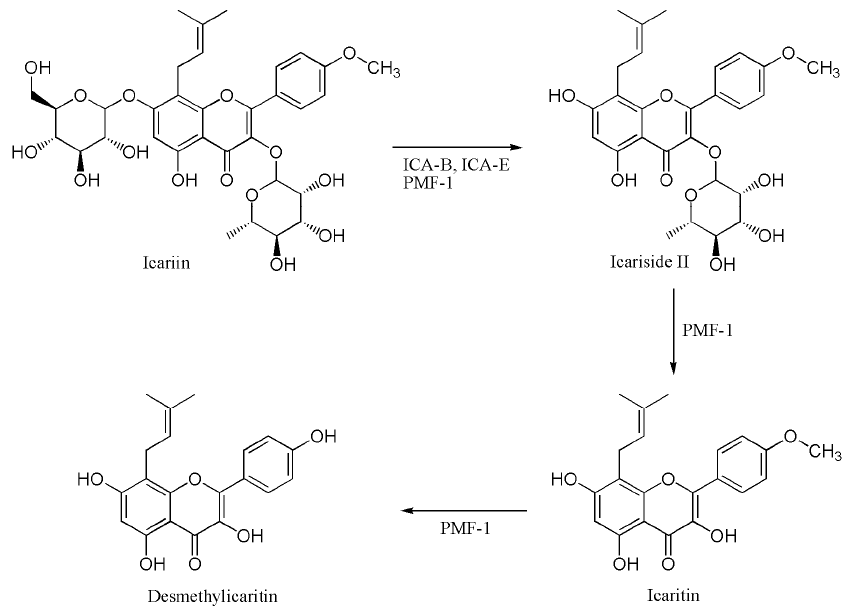
Figure 6. Proposed metabolic pathway of icariin in human intestine.